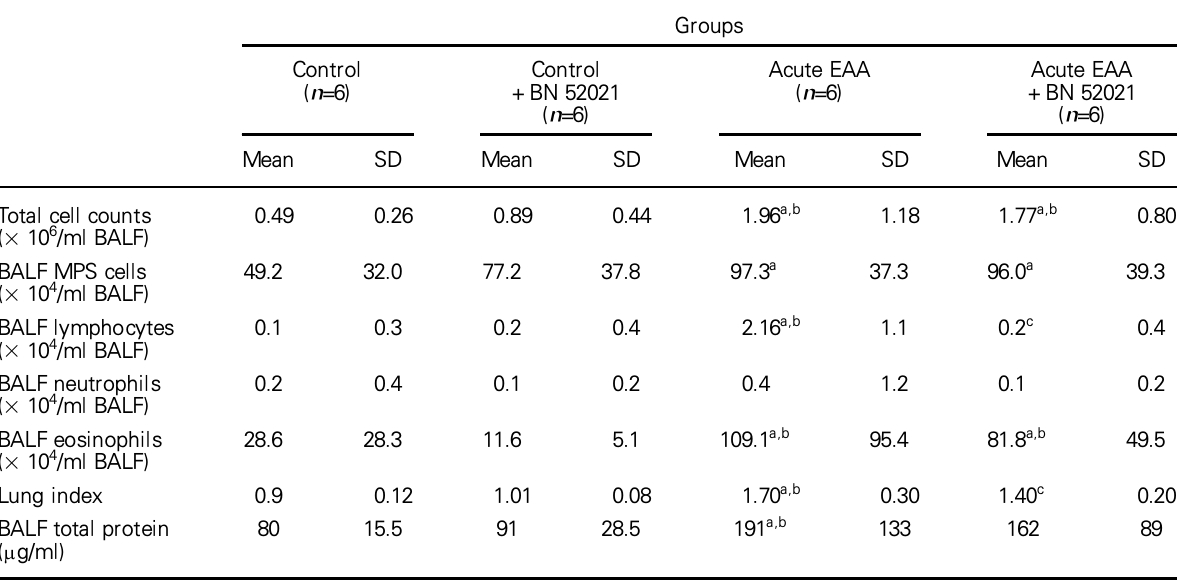
Table 1. Elemental parameters in study groups